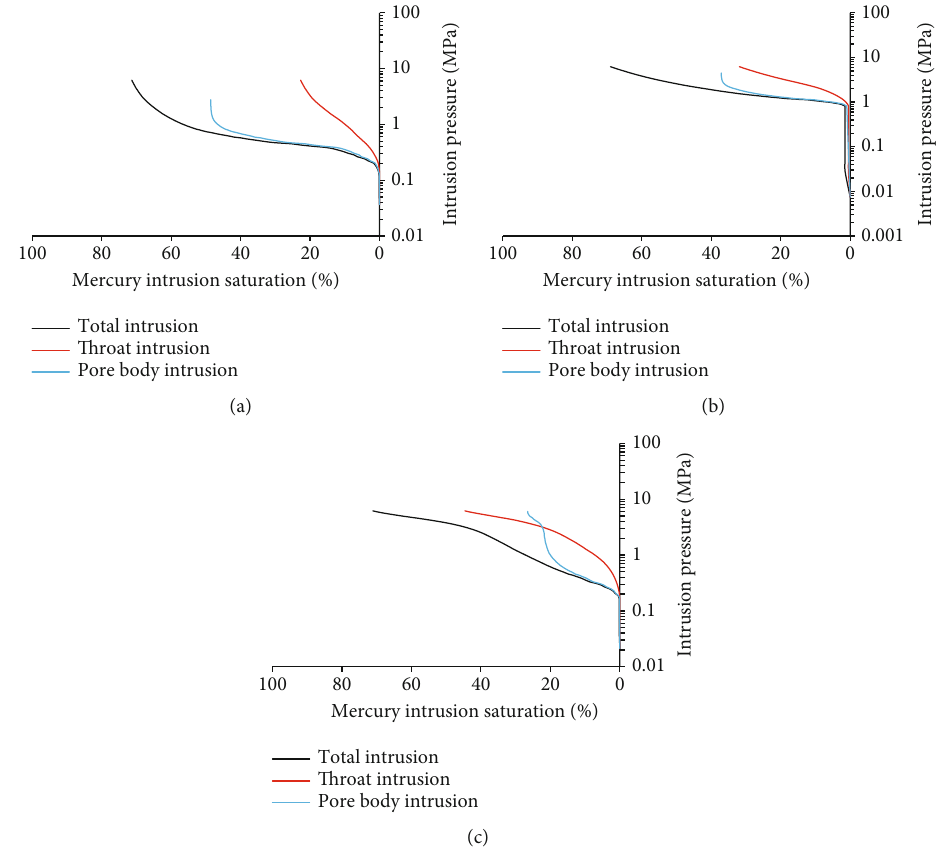
Figure 4: Constant rate mercury injection curves of the three typical